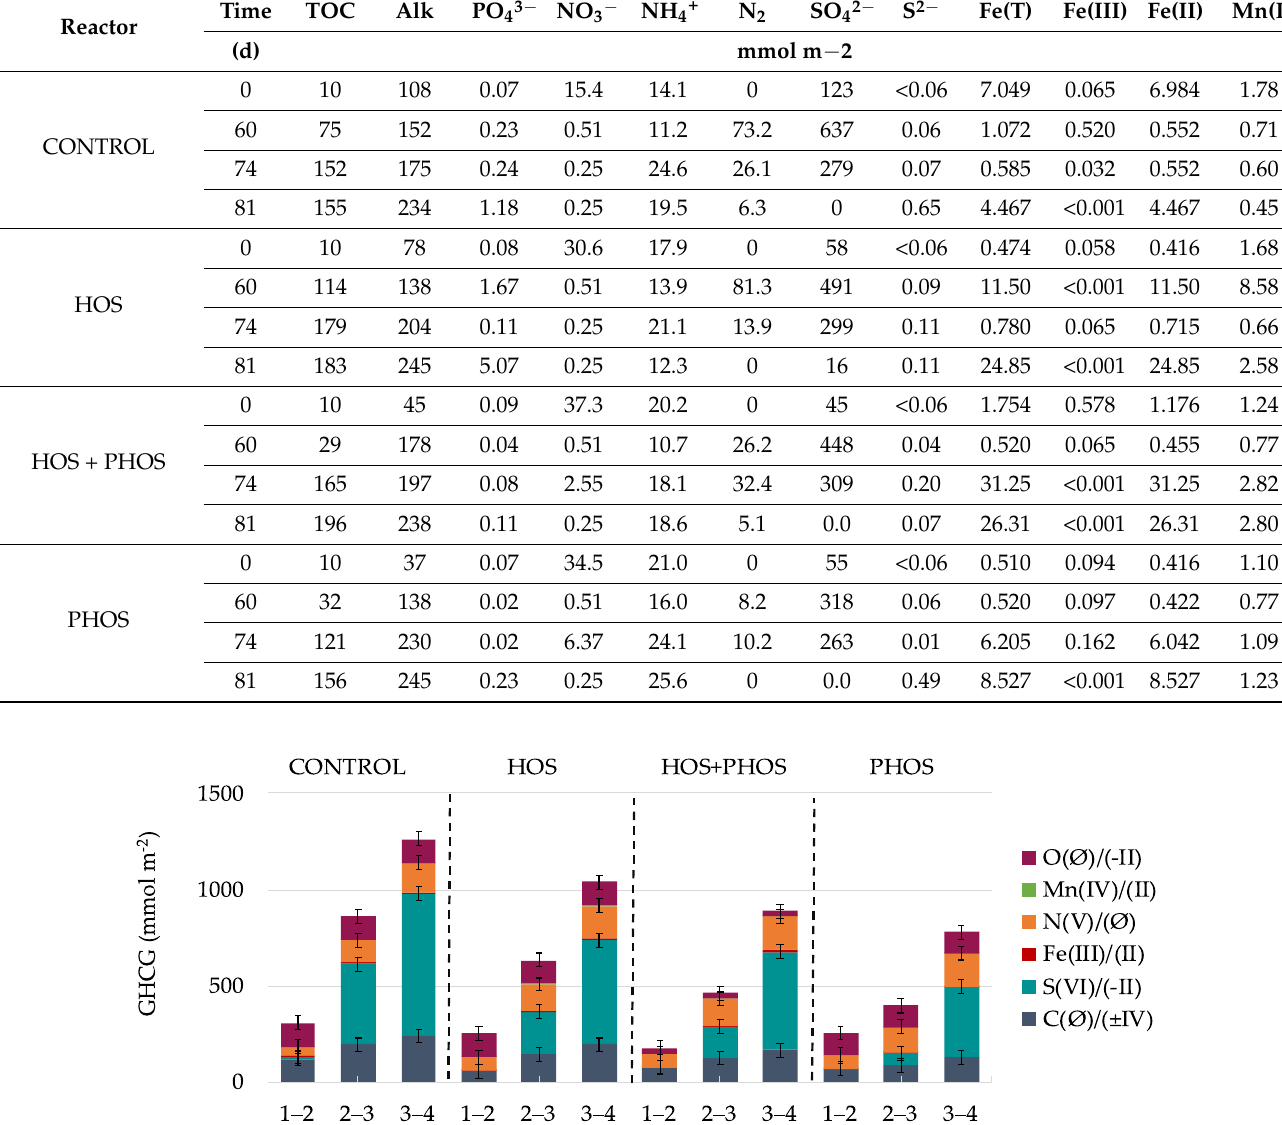
Table 6. Amounts of aqueous components per unit area in experimental reactors. Water volume = 4.8 L. Reactor area = 0.0269 m 2 .